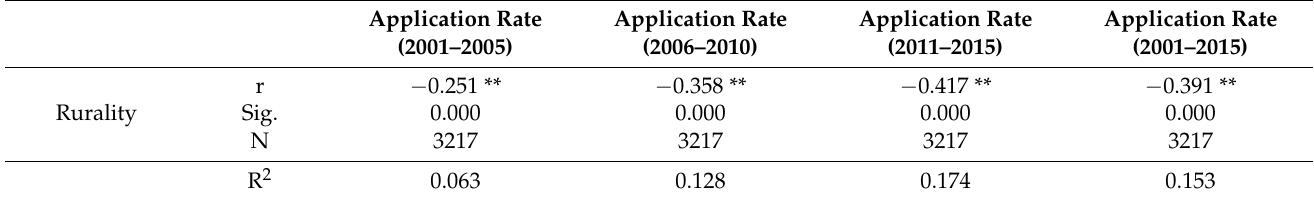
Table 2. Correlation coefficients between rurality and application rate at the county